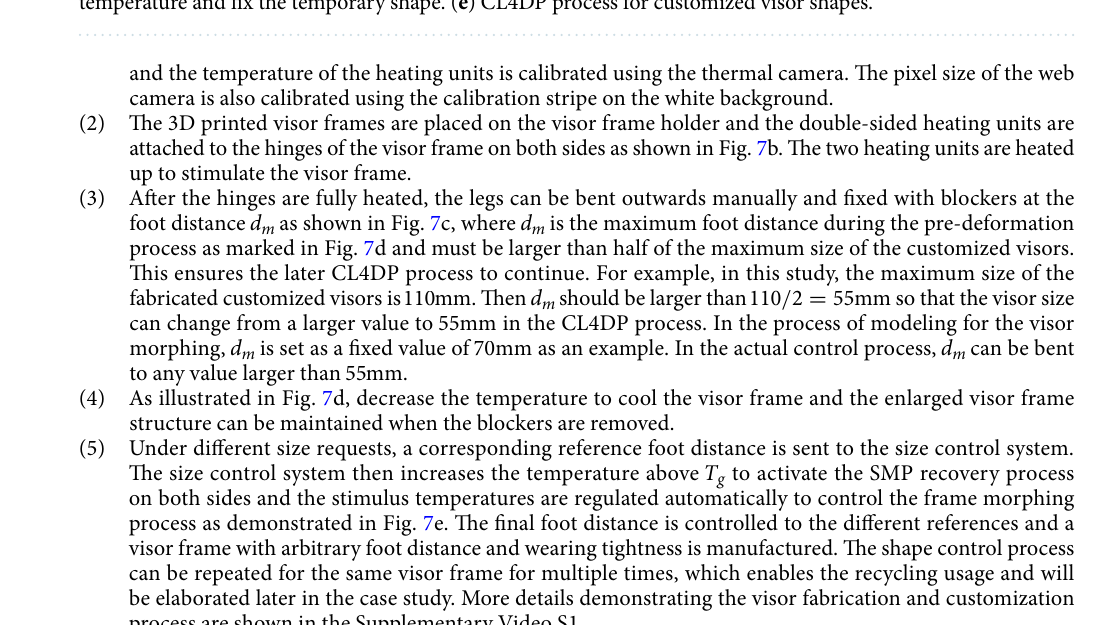
Figure 7. Operation processes for customized visor fabrication. ( a ) 3D print the visor frame. ( b ) Mount the printed visor frame. ( c ) Heat the visor frame and manually deform it to a larger size. ( d ) Cool down the temperature and fix the temporary shape. ( e ) CL4DP process for customized visor